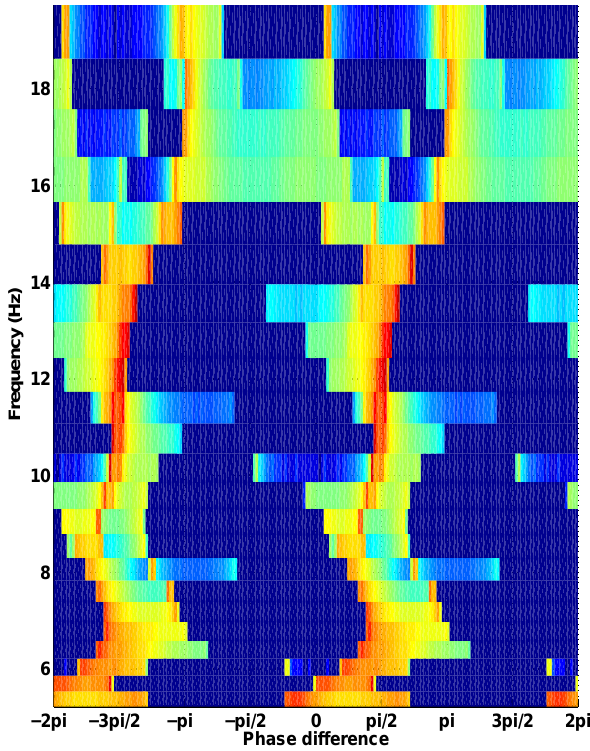
Fig. 14. The ω − k joint spectrum calculated from the two perpen- dicular electric field components E 13 and E 41 for the third